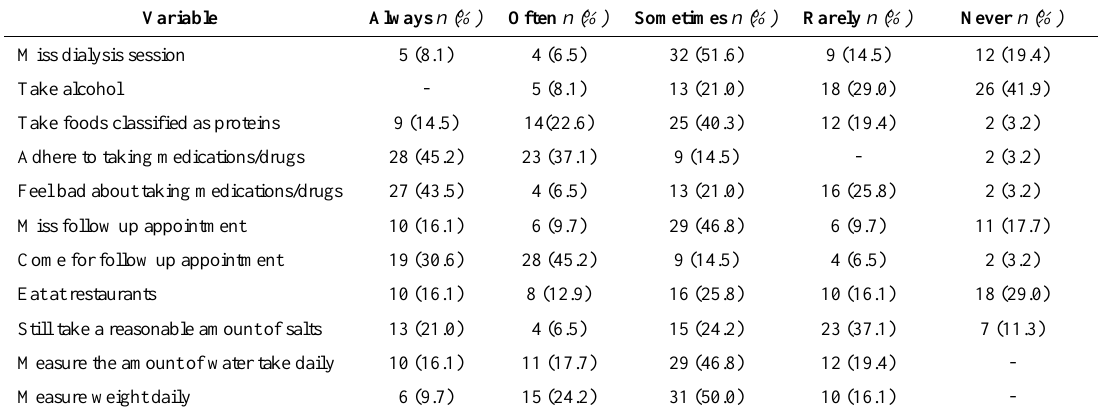
Positive Perception Negative